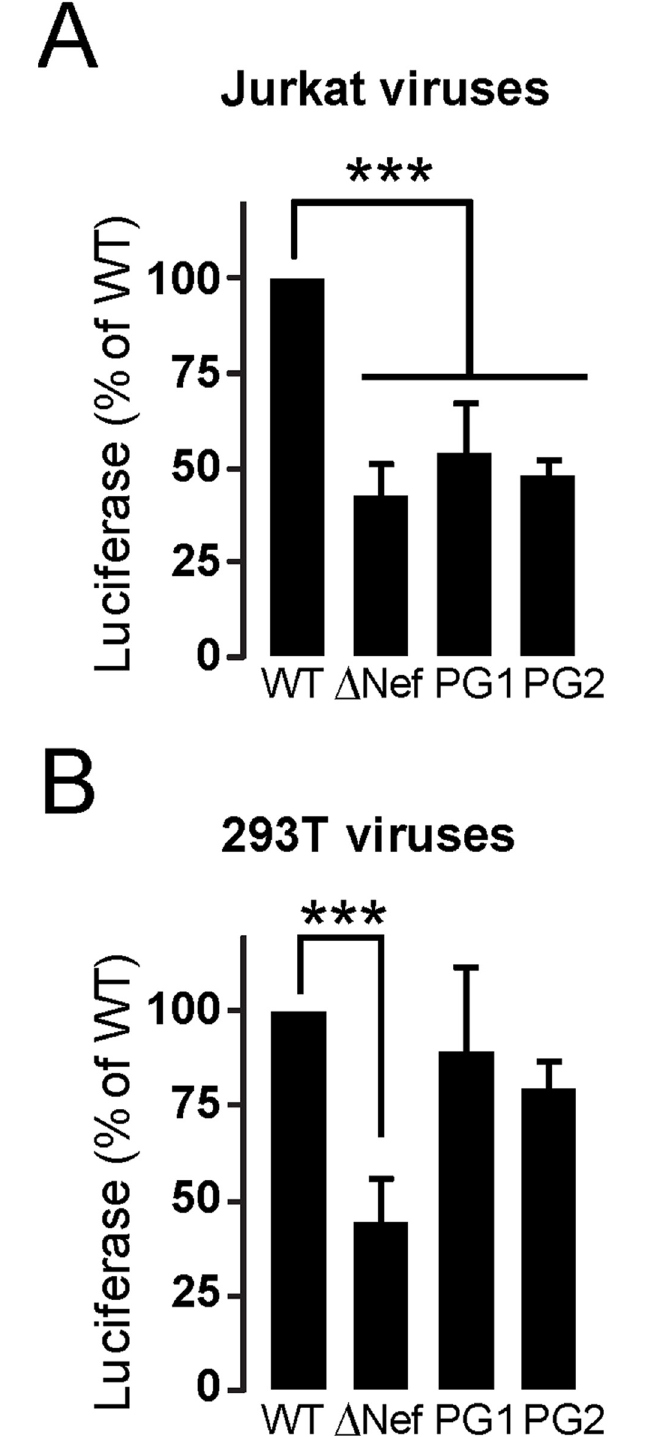
Fig 7. Nef-GPG motif is required for Nef-enhanced infectivity of HIV-1. Relative infectivity of HIV- 1expressing Nef-GPG mutations produced in Jurkat (A) or 293T (B) cells. Infectivity was analysed 48h post- infection by Luciferase assays in TZM-bl reporter cells. Results are expressed as the percentage of infectivity relative to that of the wild type viruses normalized to 100%. Values are the mean ± SD of three independent infections, each measured in duplicate. *** , p <